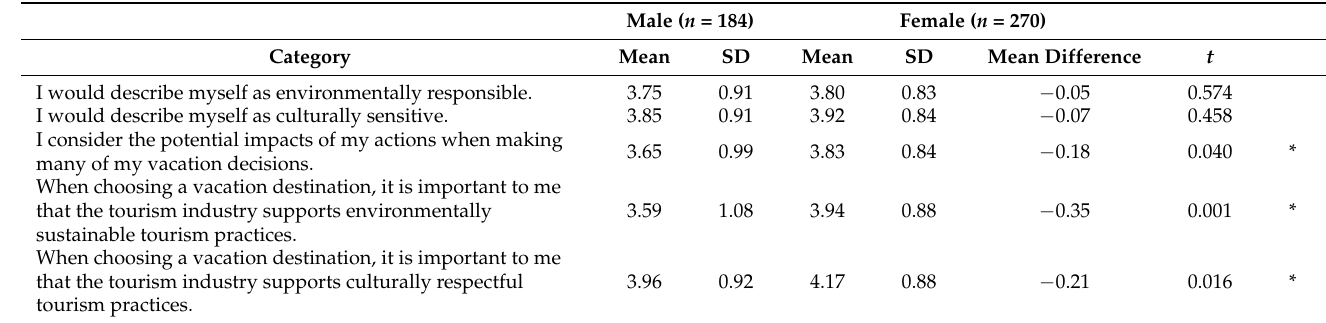
Table 3. Please indicate your level of agreement for the statements below by placing a mark in the corresponding space.